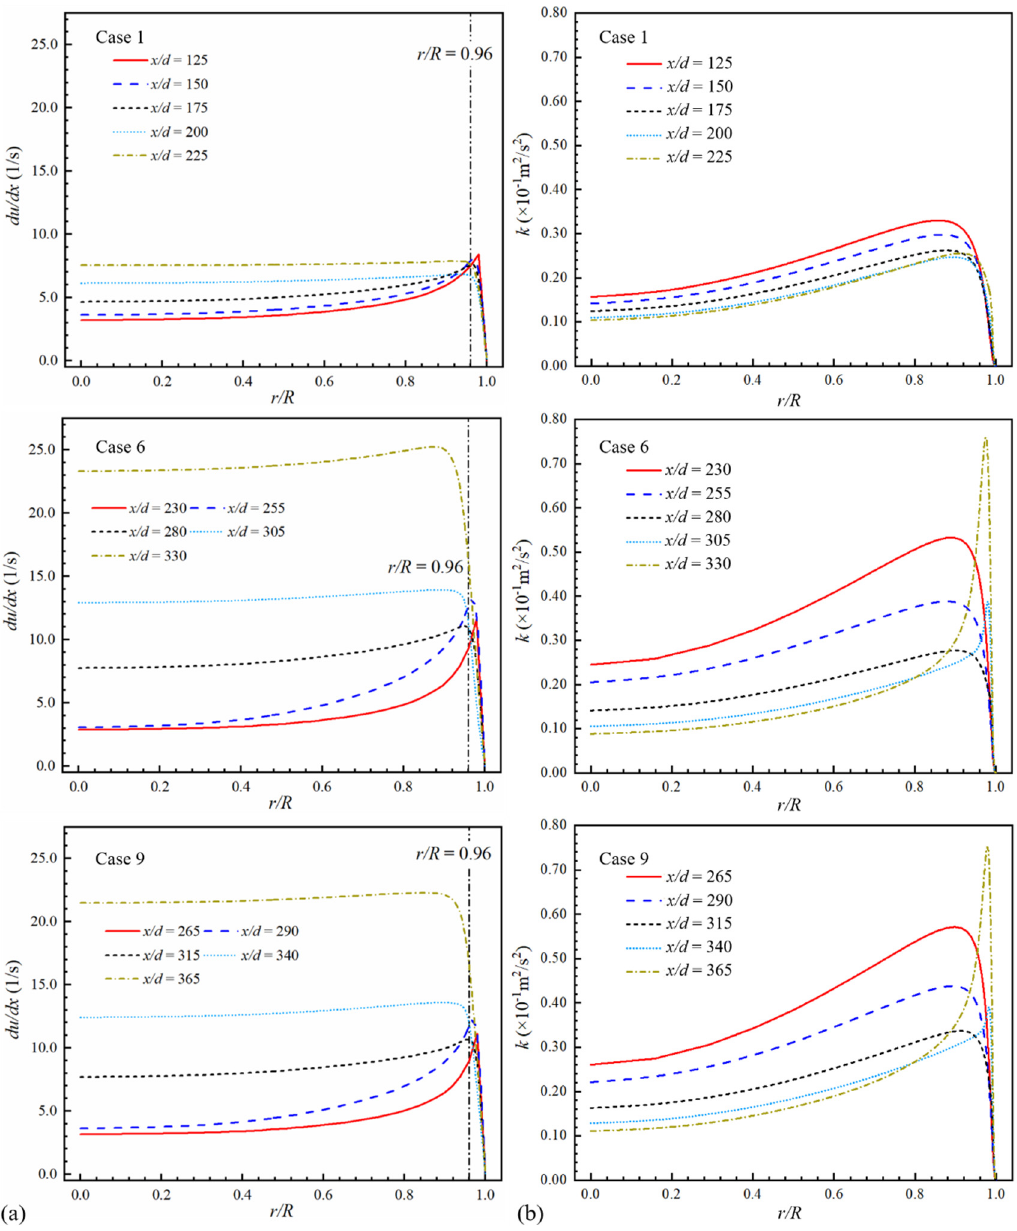
Figure 16. Flow parameters of n -decane along the flow direction: ( a ) radial distributions of axial velocity gradient; ( b ) radial distributions of turbulent kinetic energy.